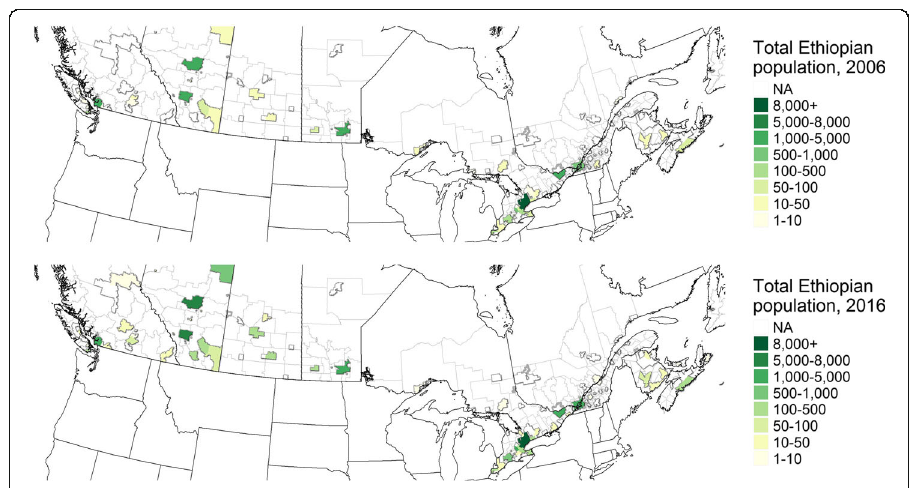
Fig. 5 Ethiopian populations in Canada's CMAs, 2006 and 2016